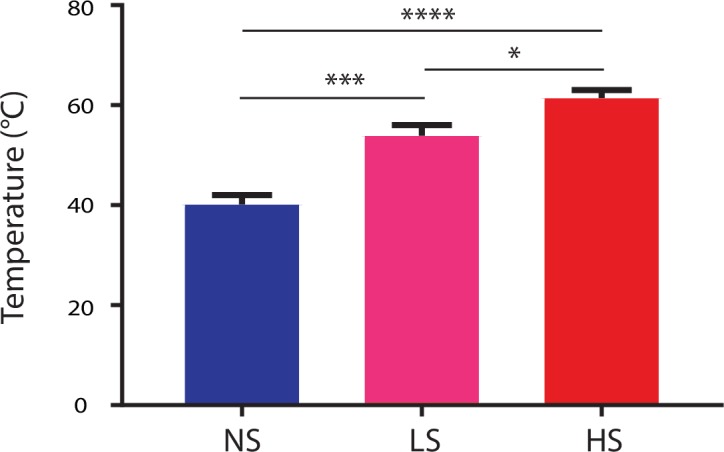
HS, LS and NS trigger high-intensity, low-intensity noxious and non-noxious stimulus respectively.Temperature measurements were conducted with a temperature sensor (Extech Instruments, 65EA, Waltham, MA) after 5 s in the case of NS, 3 s in the case of LS, and 1.5 s in the case of HS. In the cases of LS and HS, the timing of temperature measurements correlated with the averaged time of paw withdrawals. Averaged temperature at the time of recordings was 40.2 ± 1.9, 53.1 ± 2.1, and 61.4 ± 1.6 for NS, LS and HS, respectively. p=0.0003 for comparison between NS and LS, <0.0001 for comparison between NS and HS, and 0.0123 for comparison between LS and HS. n = 10–24 recording sessions. One-way ANOVA with post-hoc Bonferroni’s multiple comparison tests.